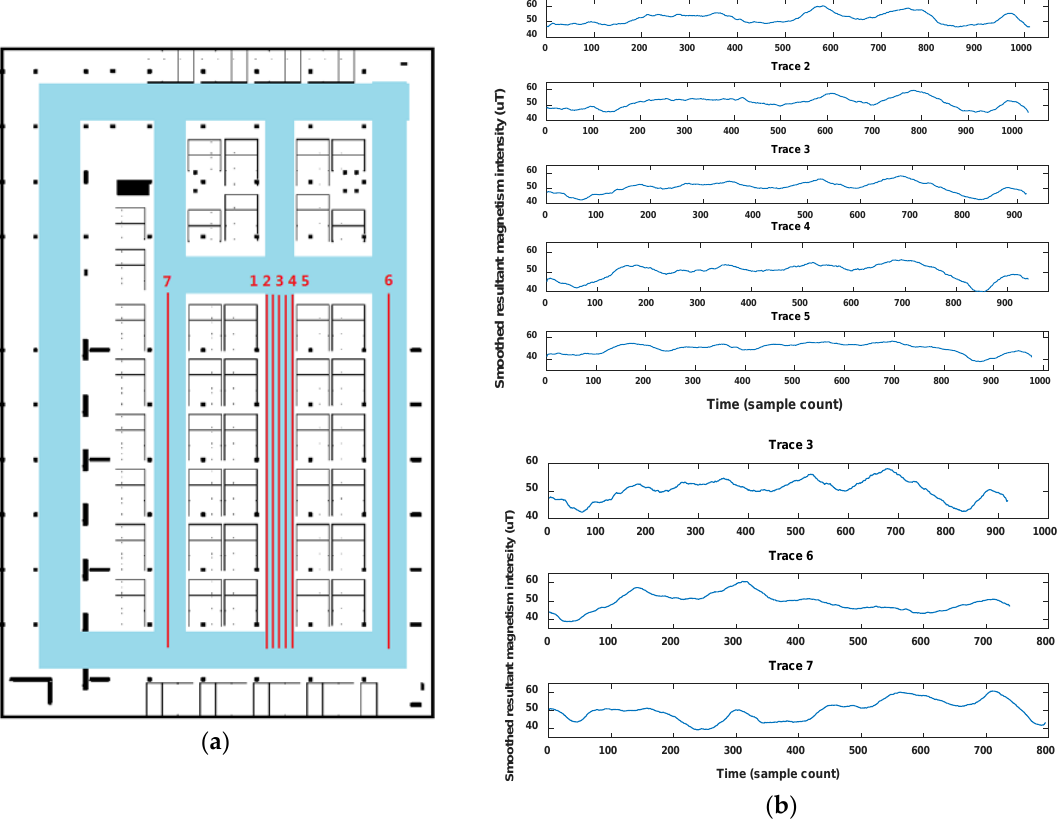
Figure 23. Data comparison for road width influence. ( a ) seven test traces (red lines); ( b ) the measured magnetism sequence of them. Table 6. Calculated similarities between seven test traces.